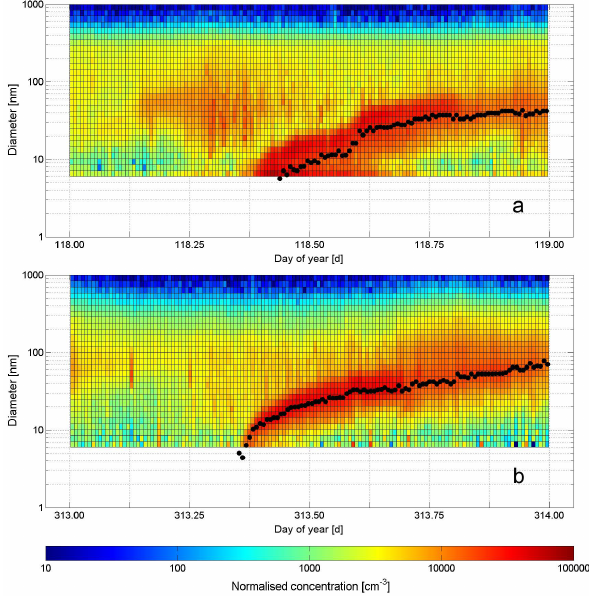
Fig. 6. Contour plots of normalised particle number concentrations measured on Tuesday, 28 April 2009 displaying road traffic emis- sion events and a new particle formation in the midday together with a consecutive particle growth (a) , and on Saturday, 8 Novem- ber 2008 showing a new particle formation and consecutive particle growth (b) . Time series of the fitted number median mobility diam- eters for the nucleation mode are indicated by black dots on both